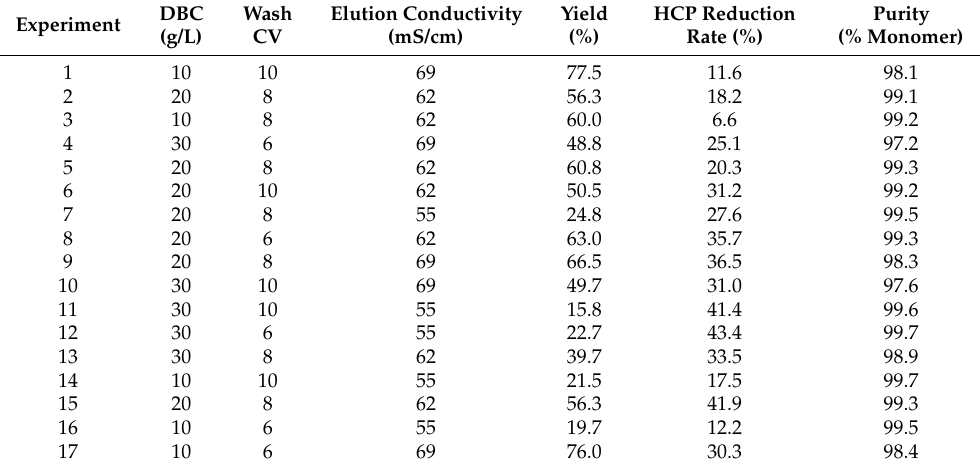
Table 3. Responses of Fc-fusion protein yield, HCP reduction rate and purity obtained for each run defined by CCF design. Triplicate experiments for the reproducibility of the model are included in this design.